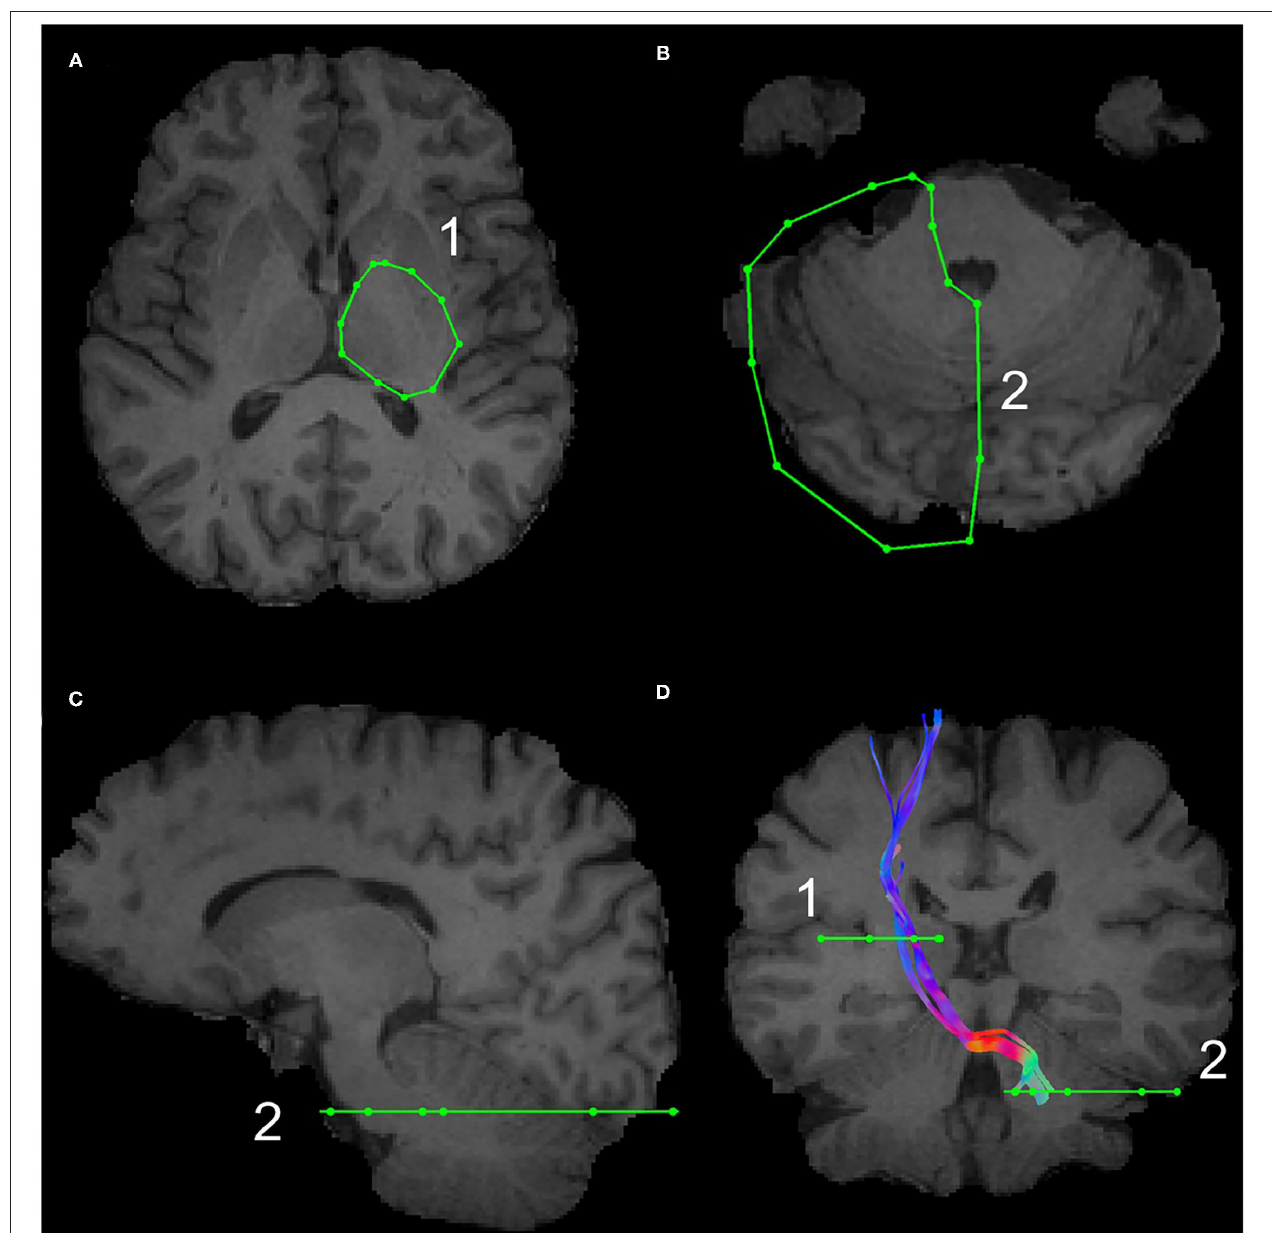
FIGURE 3 | The alternative Region of Interest(s) (ROIs) used for reconstruction of the DRTT and the SPCT. The ROI around the thalamus covering the internal capsule is shown in (A) , the ROI covering the contralateral cerebellar peduncle is shown in (B,C) . An example of the SPCT obtained using this alternative method is shown in (D)